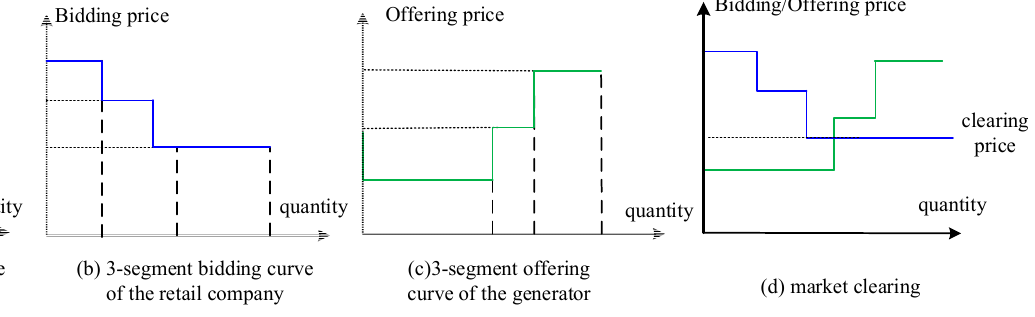
Figure 2. Illustrative figure of the market clearing.